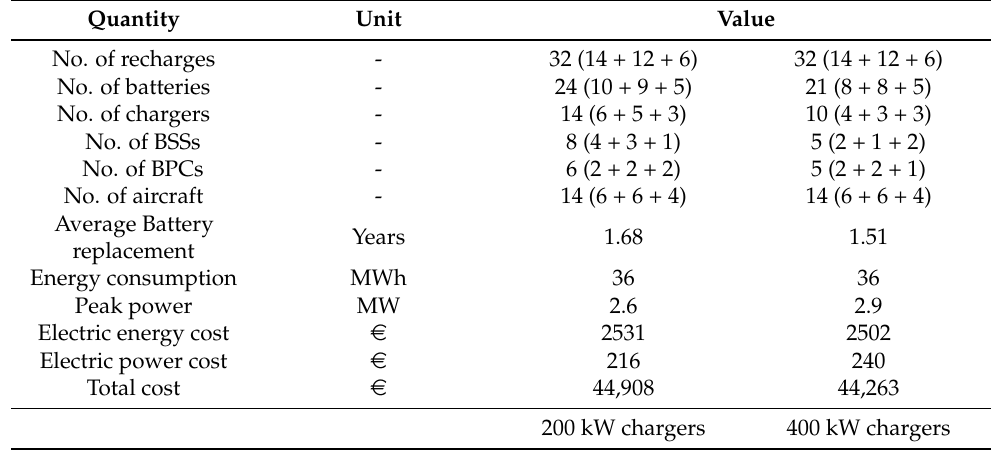
Table 11. LGAV infrastructural sizing summary (the first, second, and third in the sums between parentheses refer to HE-DH8, HE-ATR42 and HE-ATR72, respectively).